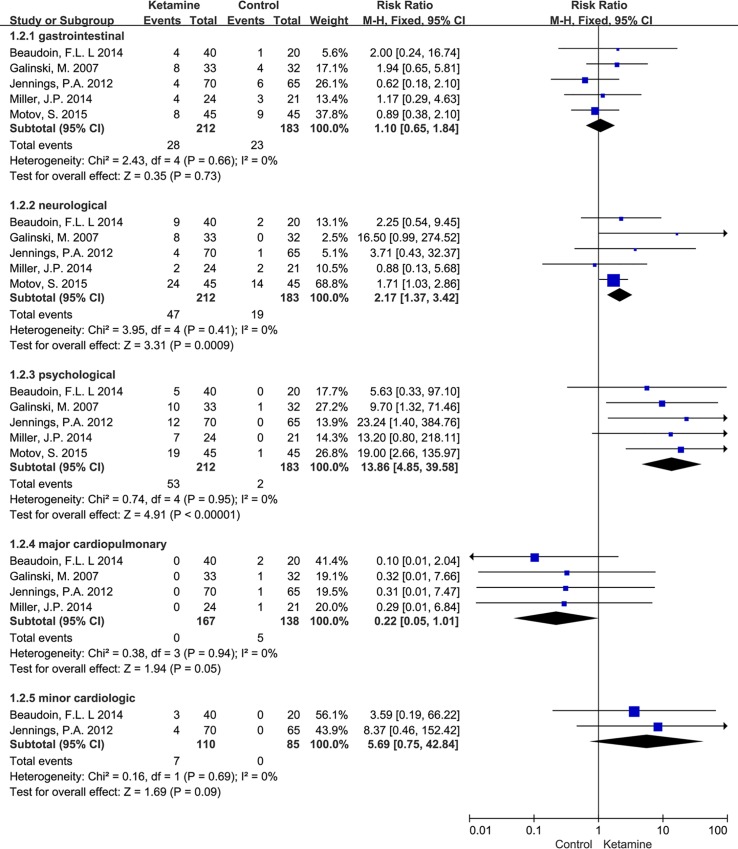
Meta-analysis of the Incidence of Adverse Events.